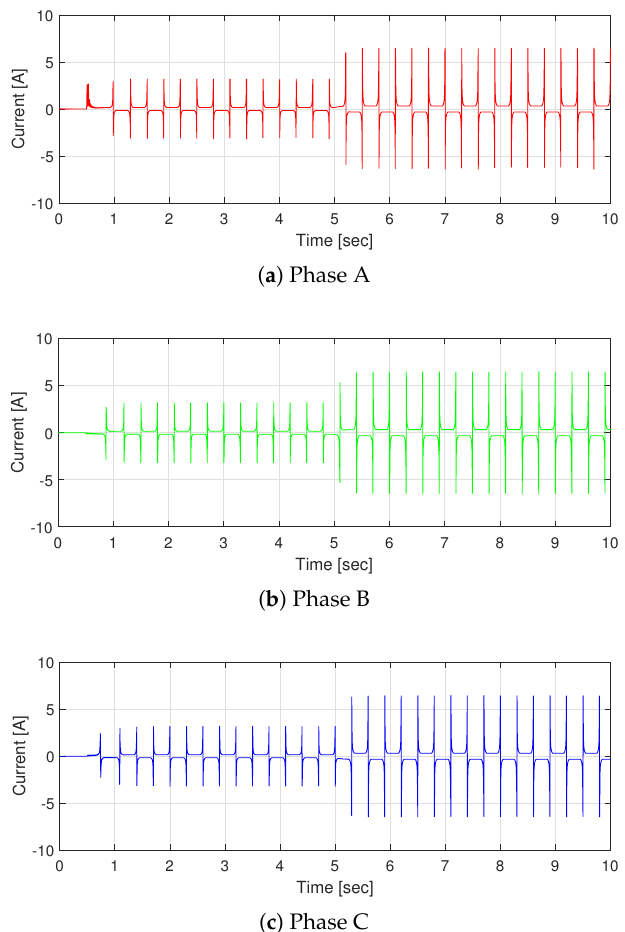
Figure 5. Desired phase